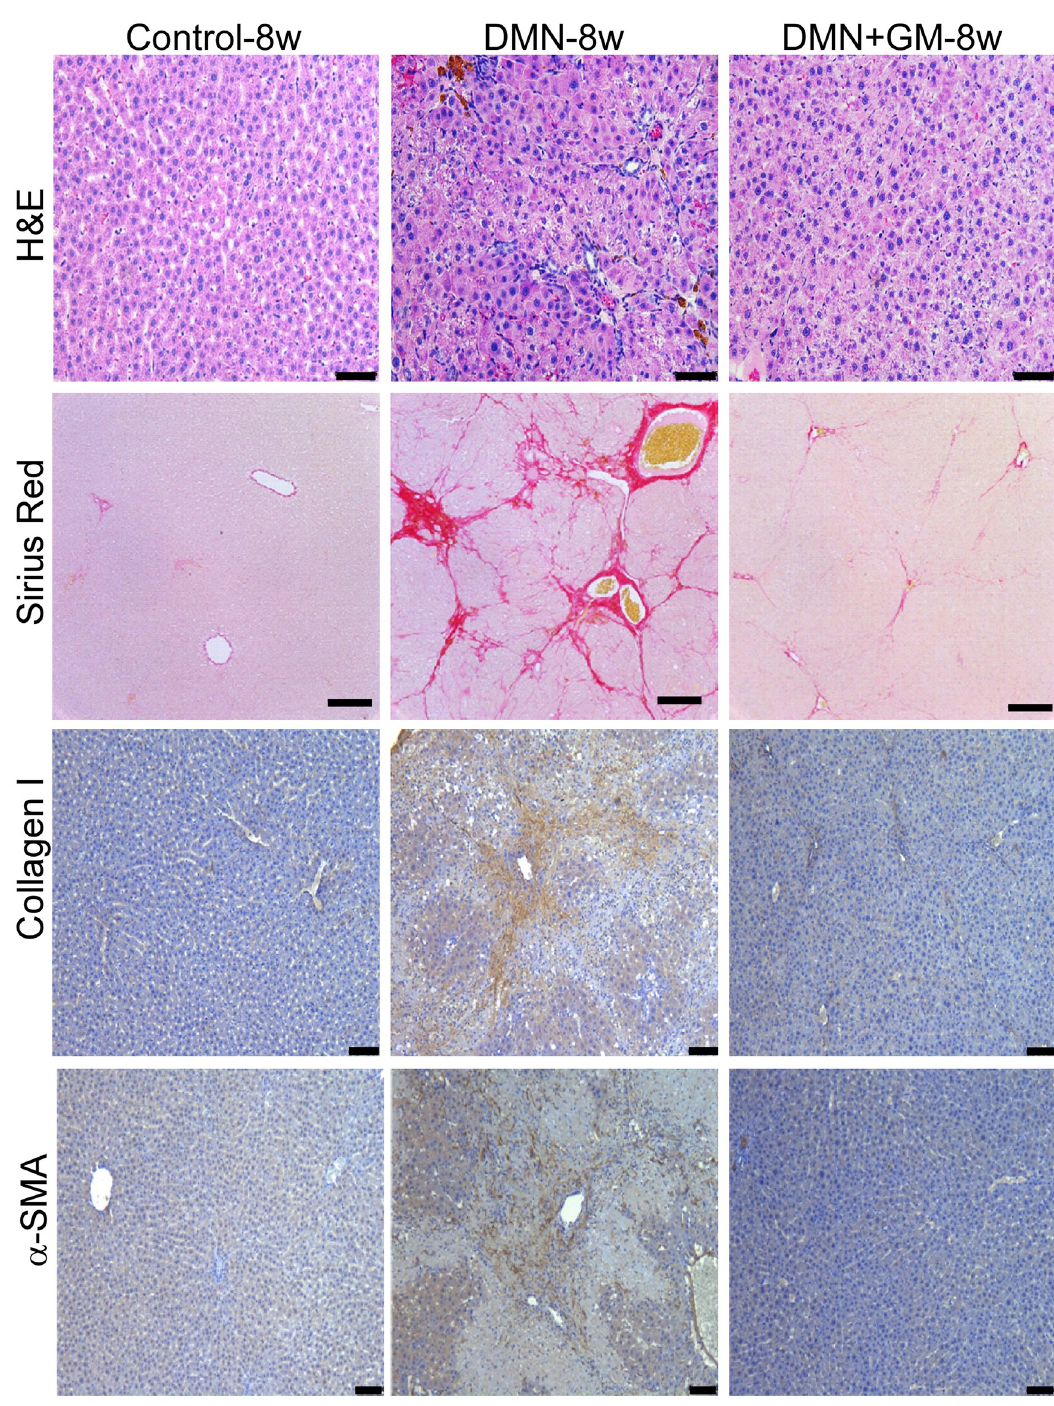
Fig 2. Effects of GM-CSF on DMN-induced histopathological changes in DMN+GM-8w group. Liver tissues were collected 57 days after initial DMN administration and fixed in 10% neutral formalin solution. Thin sections (5 μ m) were cut and stained with hematoxylin and eosin (H&E) and Sirius Red. Collagen I and α -SMA proteins were detected immunohistochemically. Scale bar = 100 μ m.